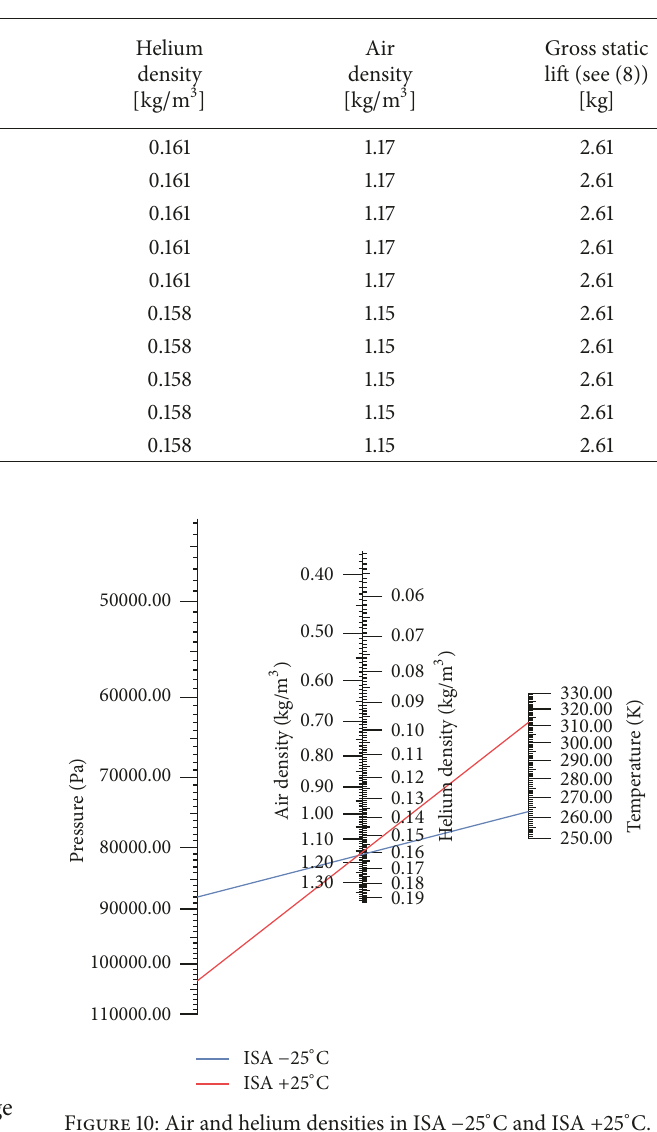
Table 8: Results in ISA − 25 ∘ C and ISA +25 ∘ C operating conditions.